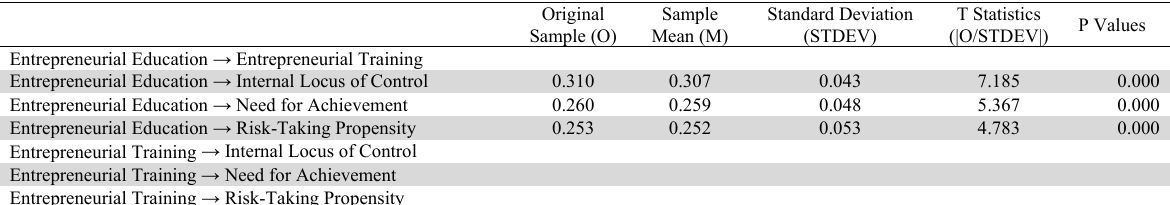
Total Indirect Effect